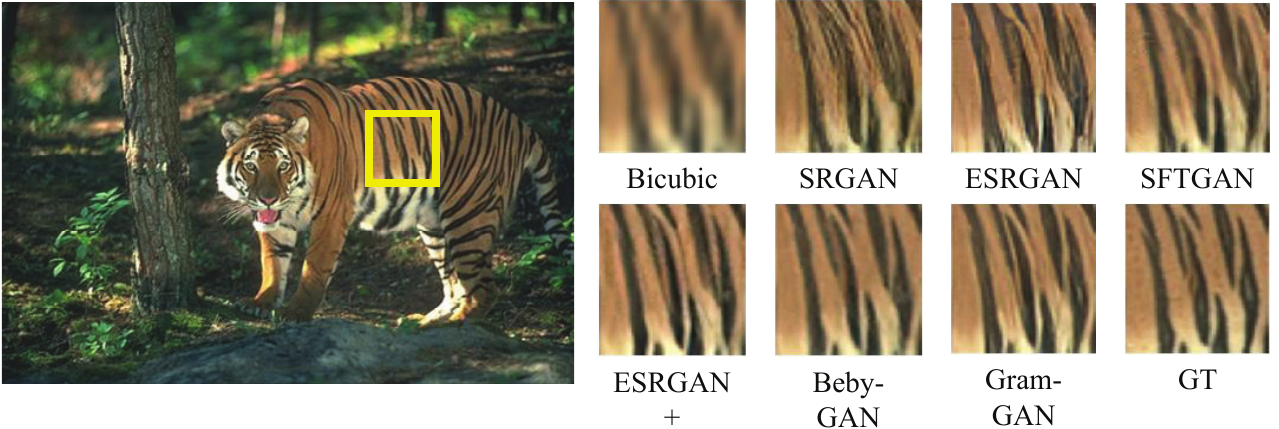
Figure 4. Visual evaluation of state-of-the-art perception-driven methods. Image “108005” from BSD100.